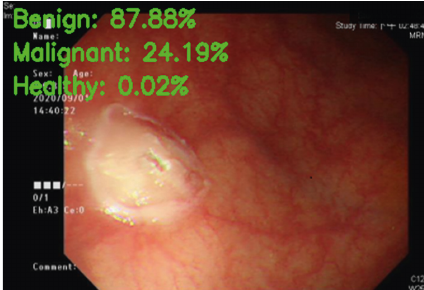
Figure 11: Tumor risk analysis result: the risk of benign tumor is 87.88%.